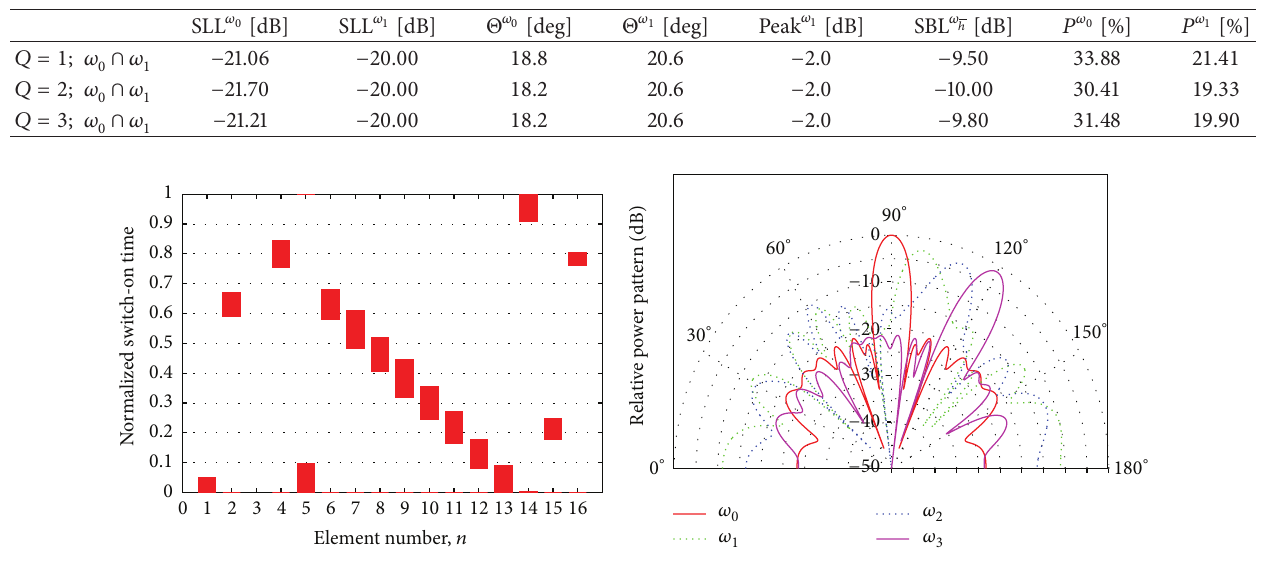
single-pulse rectangular waveforms. In fact, Table 1 shows that the configurations achieved for 𝑄 = 2 and 𝑄 = 3 provide a pattern at 𝜔 0 with lower sidelobe level and narrower 𝜔 𝑜 = −21.70 dB and SLL 𝜔 0 = beam width (i.e., SLL PSO ,𝑄=2 PSO ,𝑄=3 −21.21 dB versus SLL 𝜔 0 = −21.06 dB; Θ 𝜔 0 = PSO ,𝑄=1 PSO ,𝑄=2 Θ 𝜔 0 = 18.2 ∘ versus Θ 𝜔 0 = 18.8 ∘ ), but such solutions PSO ,𝑄=3 PSO ,𝑄=1 = bring a higher waste of power in the SRs (i.e., SR PSO ,𝑄=2 = 48.6 % versus SR = 44.7 %). 50.3 % and SR PSO ,𝑄=3 PSO ,𝑄=3